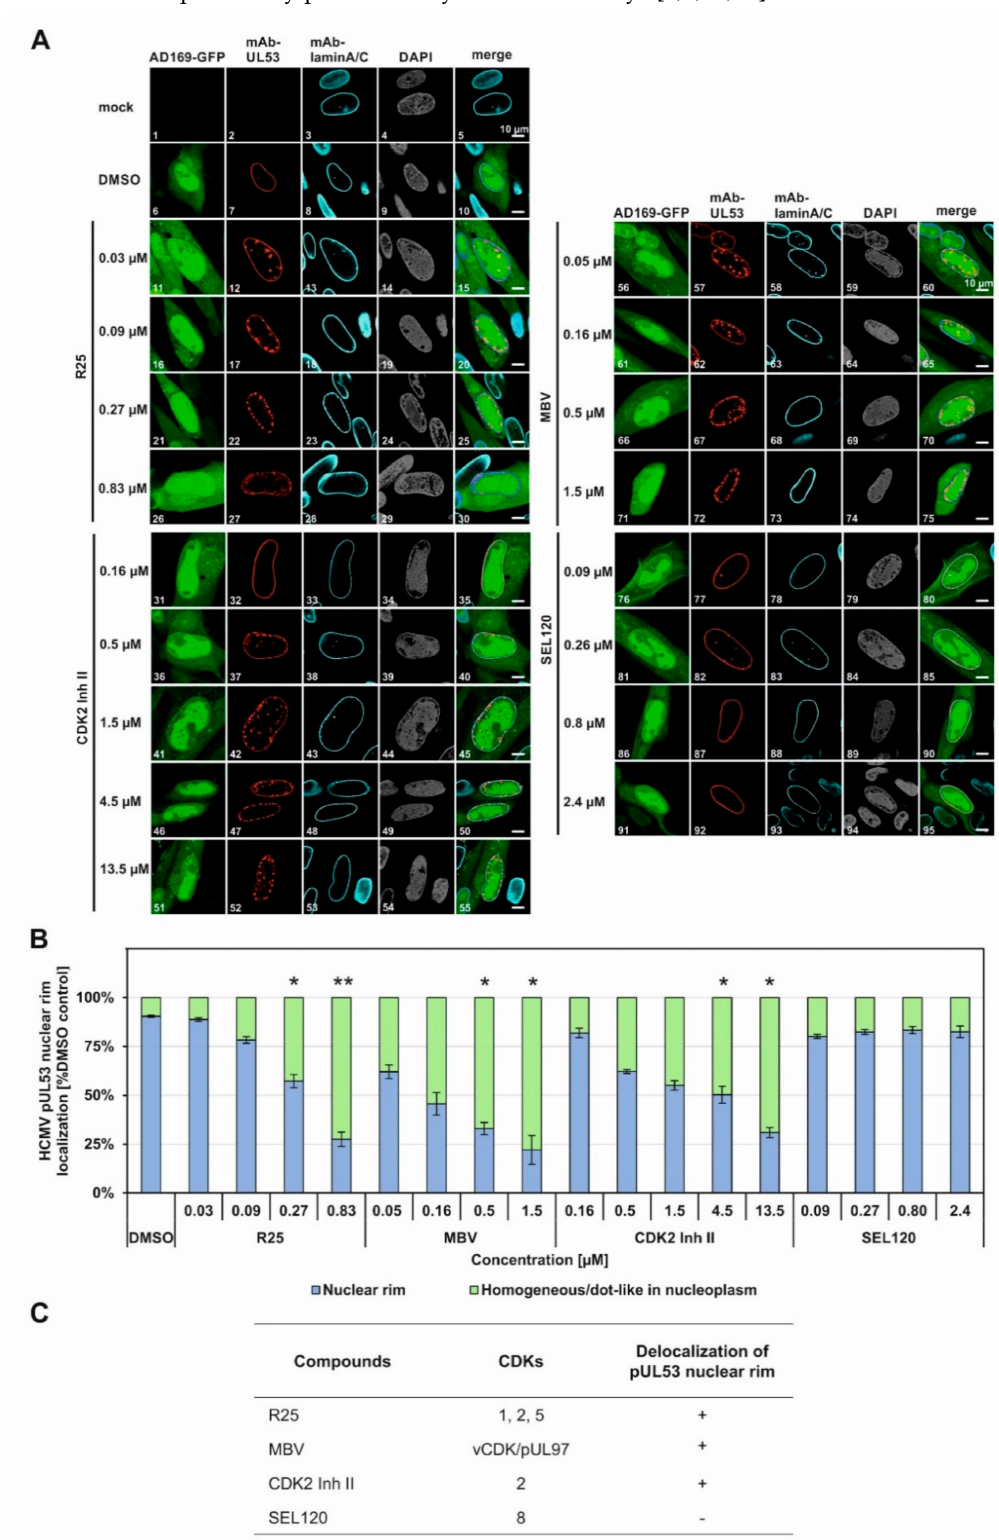
Figure 5. Effect of CDK/vCDK inhibitors on pUL53 nuclear rim localization. ( A ) Confocal imaging of NEC nuclear rim formation in HCMV AD169-GFP-infected fibroblasts under CDK/vCDK